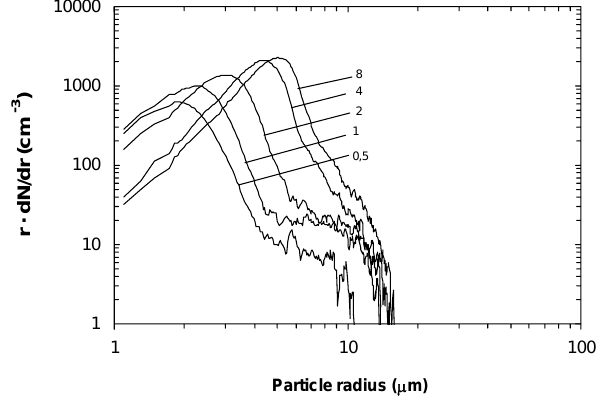
Figure 3. Observed evolution of cloud drop spectrum in the background experiment (numbers 4 Fig. 3. Observed evolution of cloud drop spectrum in the back- at the curves – time (min.) after the cloud medium formation). 5 ground experiment (numbers at the curves – time (min.) after the cloud medium formation).